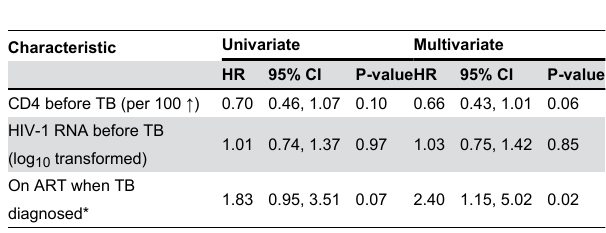
Table 3. Risk Factors for Death Among All Tuberculosis Patients.